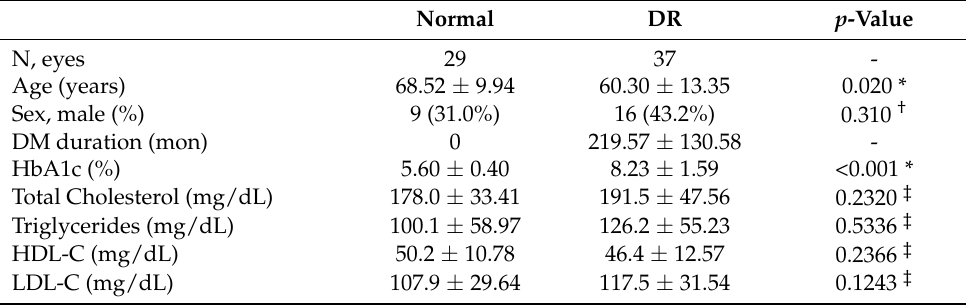
Table 1. Baseline demographic and clinical characteristics of the study participants. Normal DR p